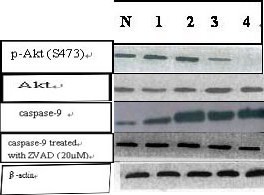
Western blot analysis of Akt, phosphor-Akt(S473), caspase-9, and caspase-9 treated with ZVAD (20 μmol/L). N: no treatment group; Lanes1, 2, 3, and 4: treatment with LY294002(10 μmol/L, 25 μmol/L, 50 μmol/L, and 75 μmol/L respectively).